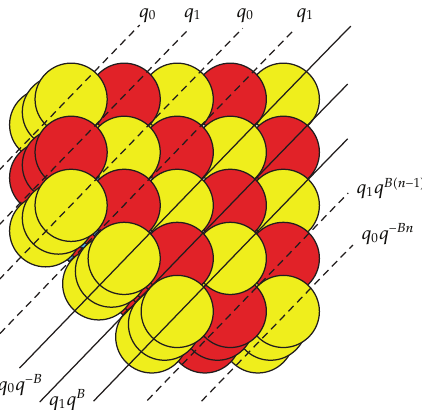
Figure 20: Refined pyramid crystal for the resolution of C 3 / Z 2 singularity, in the chamber corresponding to n stones in the top row, as seen from the bottom (cid:4) i.e., a negative direction of z -axis (cid:5) . Even though the three-dimensional shape of the crystal is di ff erent than in the conifold case, the assignment of colors is the same, see Figure